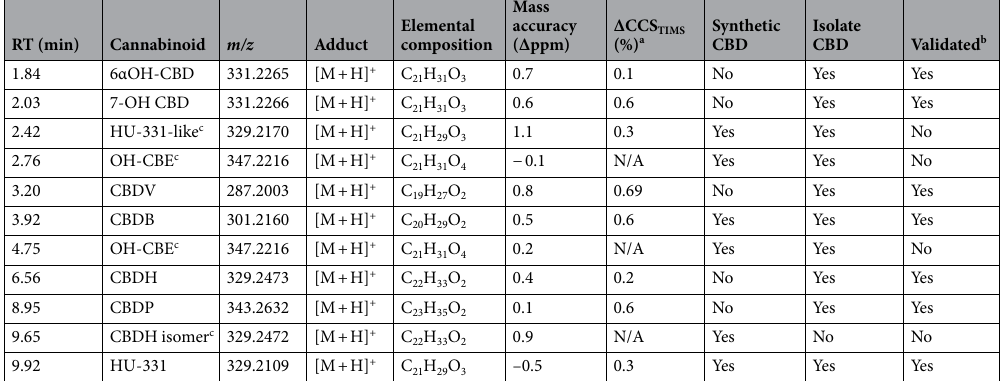
Table 1. Cannabinoid impurities and degradants identified by UHPLC-TIMS-TOF-MS in CBD e-liquids detected 1 day after formulation into e-liquid. CBDB cannabidibutol; CBDH cannabidihexol; CBDP cannabidiphorol; CBDV cannabidivarin;CBD-HQ; CBD hydroxyquinone (HU-331); CBE cannabielsoin; OH‑CBD hydroxy cannabidiol; OH‑CBE hydroxy-cannabielsoin. a ΔCCS TIMS was estimated by comparing the CCS value with that obtained for the certified reference material (CRM) on the same instrument. b Validated by matching to an analytical standard based on retention time, exact mass measurement, isotopic pattern, collisional cross section, and MS 2 fragmentation. c Putative